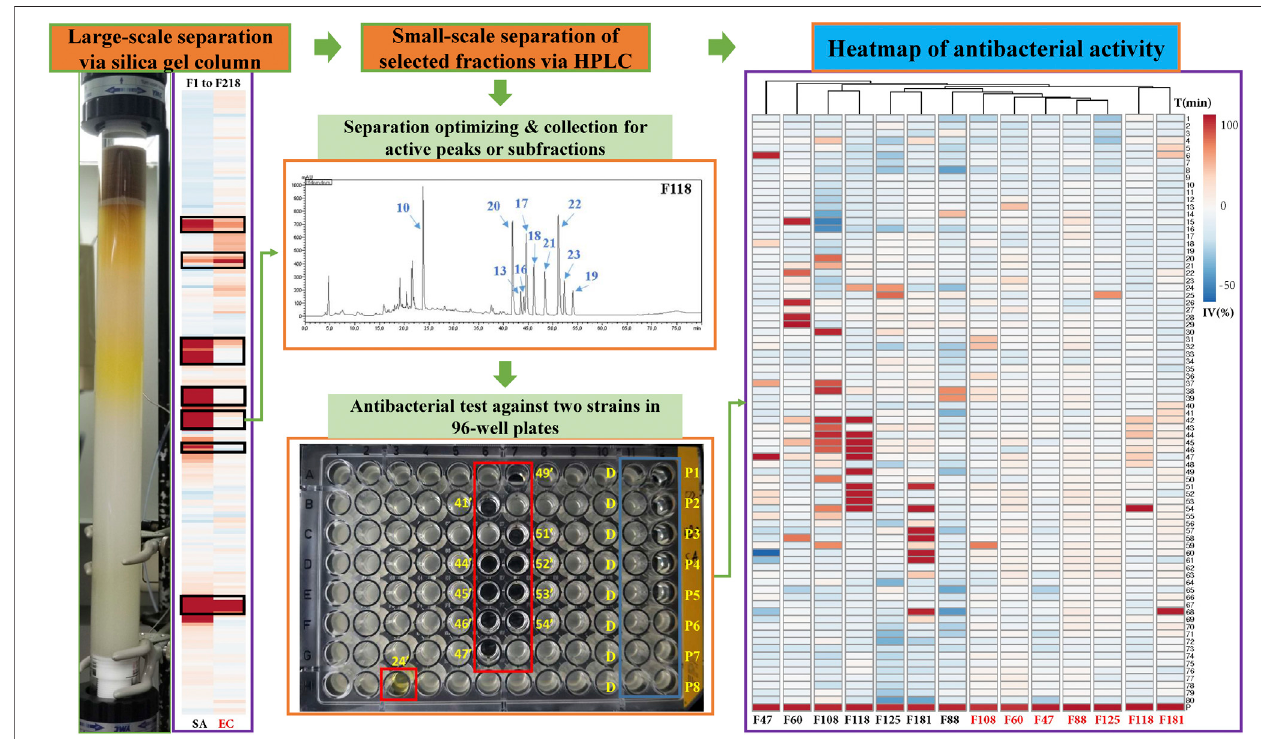
FIGURE2| SeparationofantibacterialcompoundsfromKumubasedonsuccessivechromatographiccolumns(normalandreversed-phasechromatography)and the heatmap of the bioactivity of their factions against a representative Gram-positive strain (SA: S. aureus ) and Gram-negative strain (EC: E. coli ). F: fractions of preparative silica gel column, D: negative control, DMSO, P1-8: positive control (cipro fl oxacin) in different concentrations, IV: inhibition value, T: time for collection in minutes, such as 24 ’ and 41 ’ .